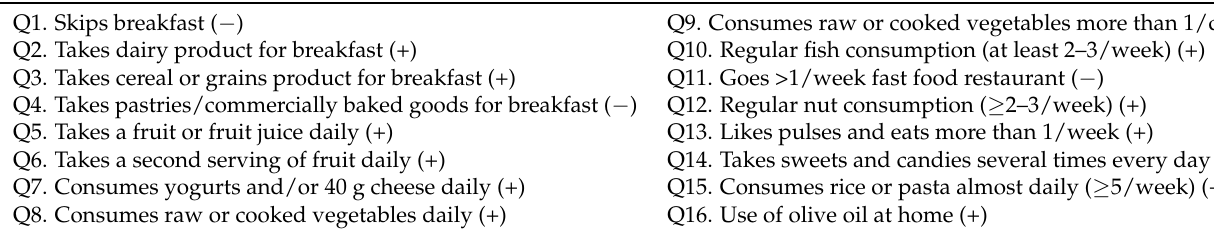
Table 1. Adherence to the Mediterranean Diet Questionnaire